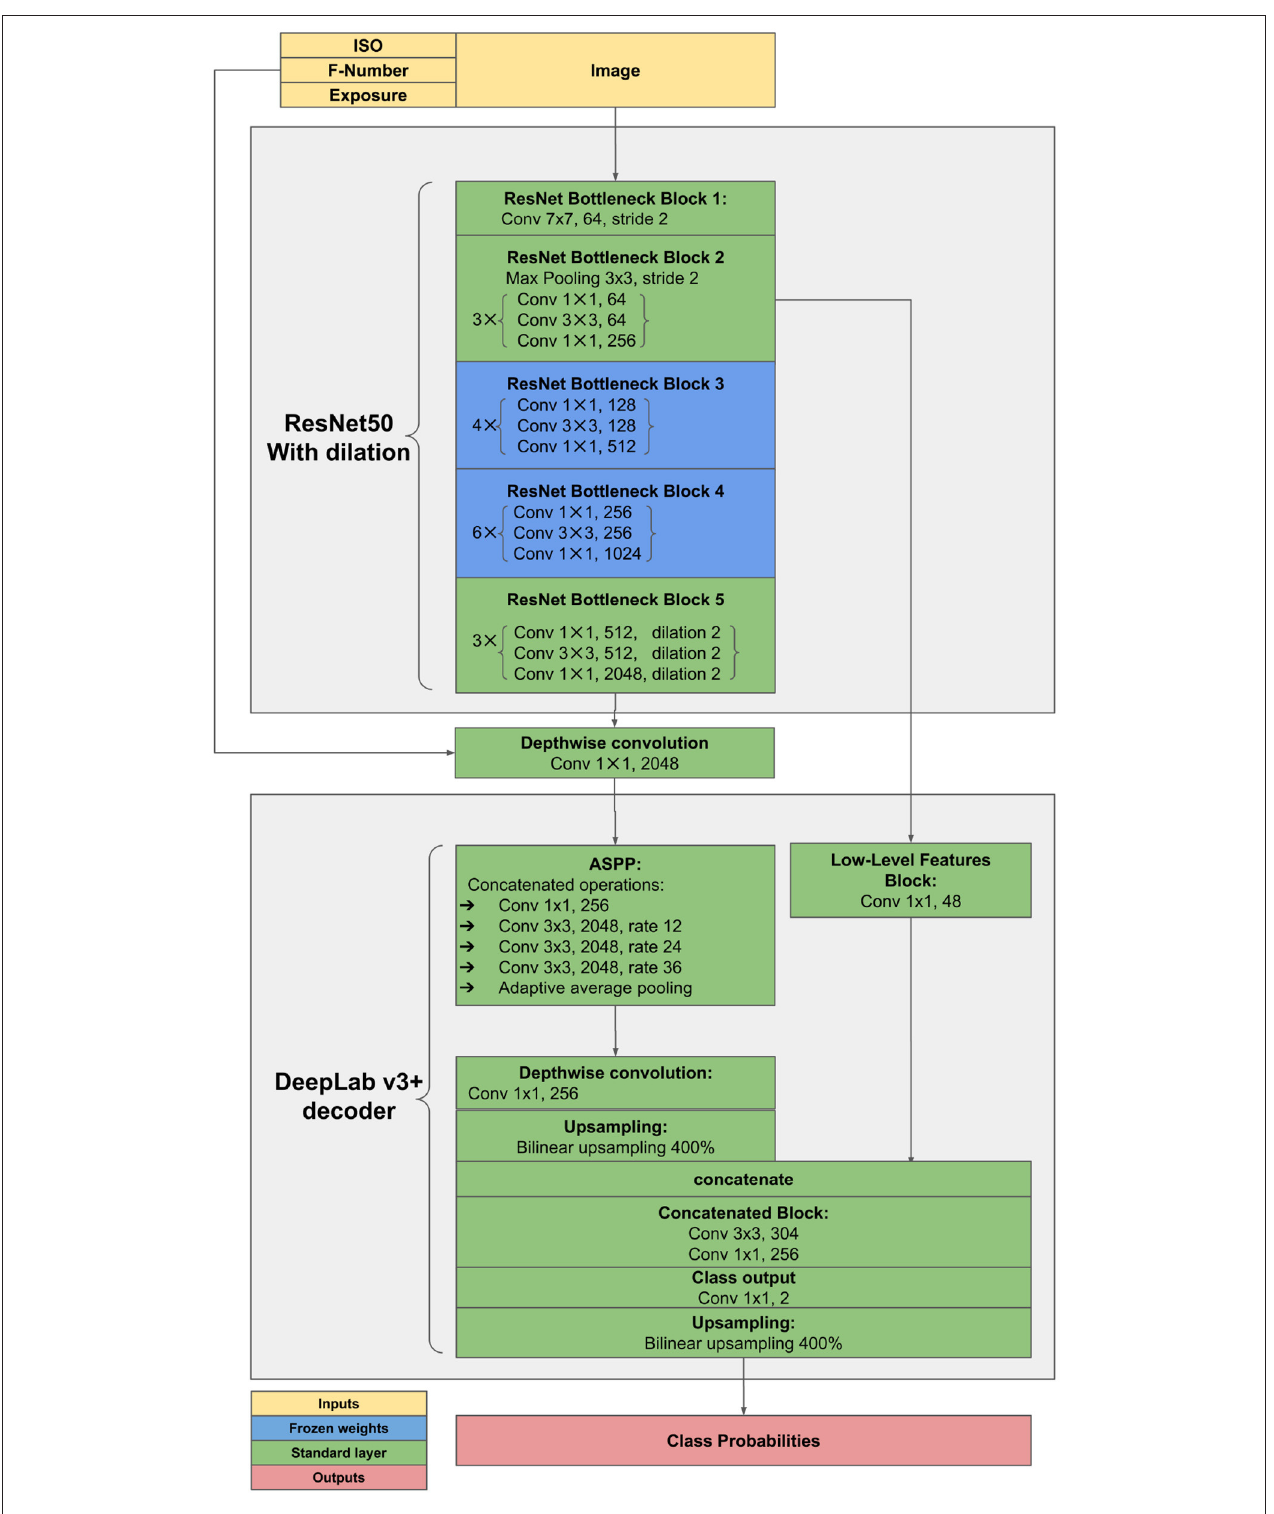
FIGURE 3 | Adjustments to ResNet encoder. Diagram denotes feature injection pathways and frozen layers during training. Blocks correspond to the blocks of convolutions in the original ResNet architecture.